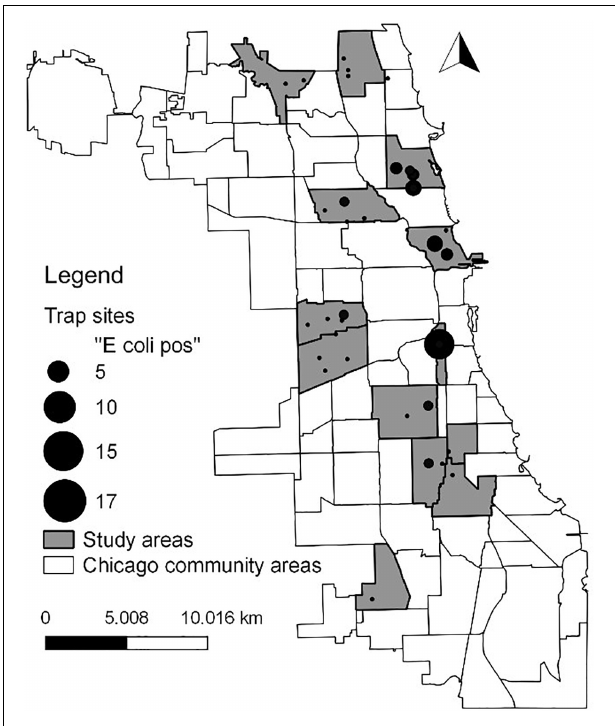
FIGURE 1 | Map showing locations of E. coli isolates. Circle size is proportional to the number of